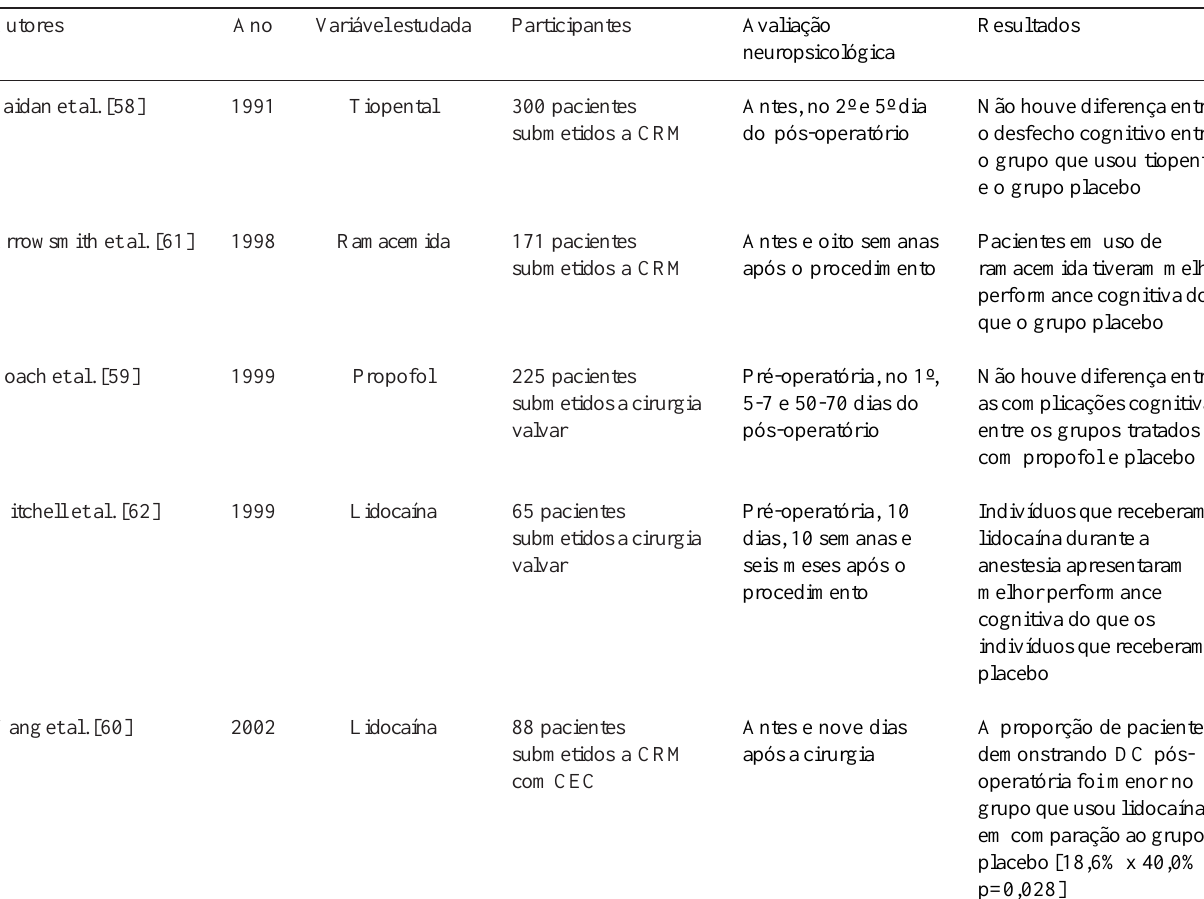
Tabela 5. Fármacos